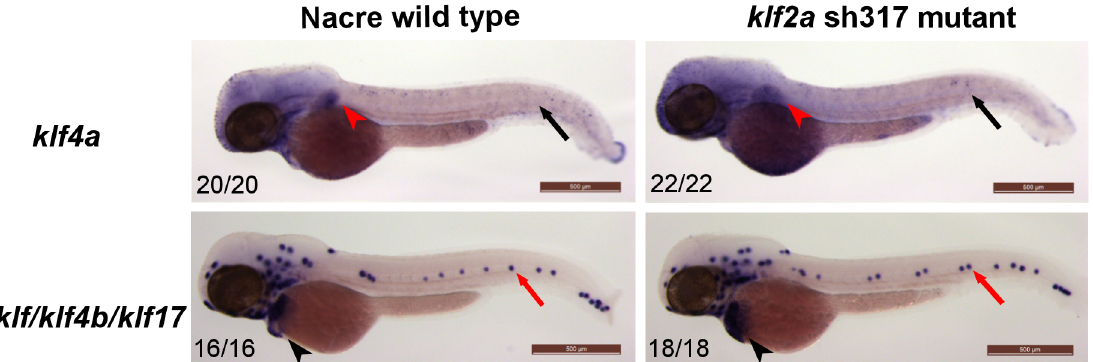
Fig 9. klf4a and biklf/klf4b/klf17 expression patterns do not differ between wildtype and klf2a sh317 mutants at 48hpf. klf4a expression was detected in epidermis (black arrows) and pectoral fins (red arrowheads) and biklf/klf4b/klf17 expression was detected in neuromasts of lateral line organ (red arrows) and in hatching glands (black arrowheads) of wildtype embryos and klf2a sh317 mutants in keeping with previously published data [17, 47] No vascular expression of klf4a or biklf/klf4b/klf17 could be detected in any of the wildtype embryos or klf2a sh317 mutants examined. Figures in bottom left corner of each image indicate the number of embryos with similar staining patterns out of total number of embryos examined. Scale bar = 500 μ m.